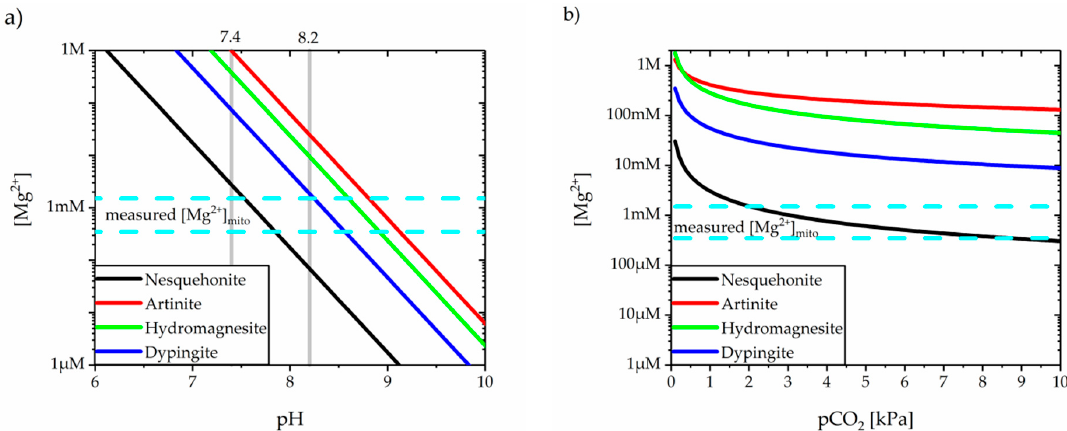
Figure 3. The calculated equilibrium concentrations of free magnesium ( a ) as functions of pH at 35 °C and pCO 2 = 7 kPa, ( b ) as a function of partial pressure of carbon dioxide at 35 °C and pH =